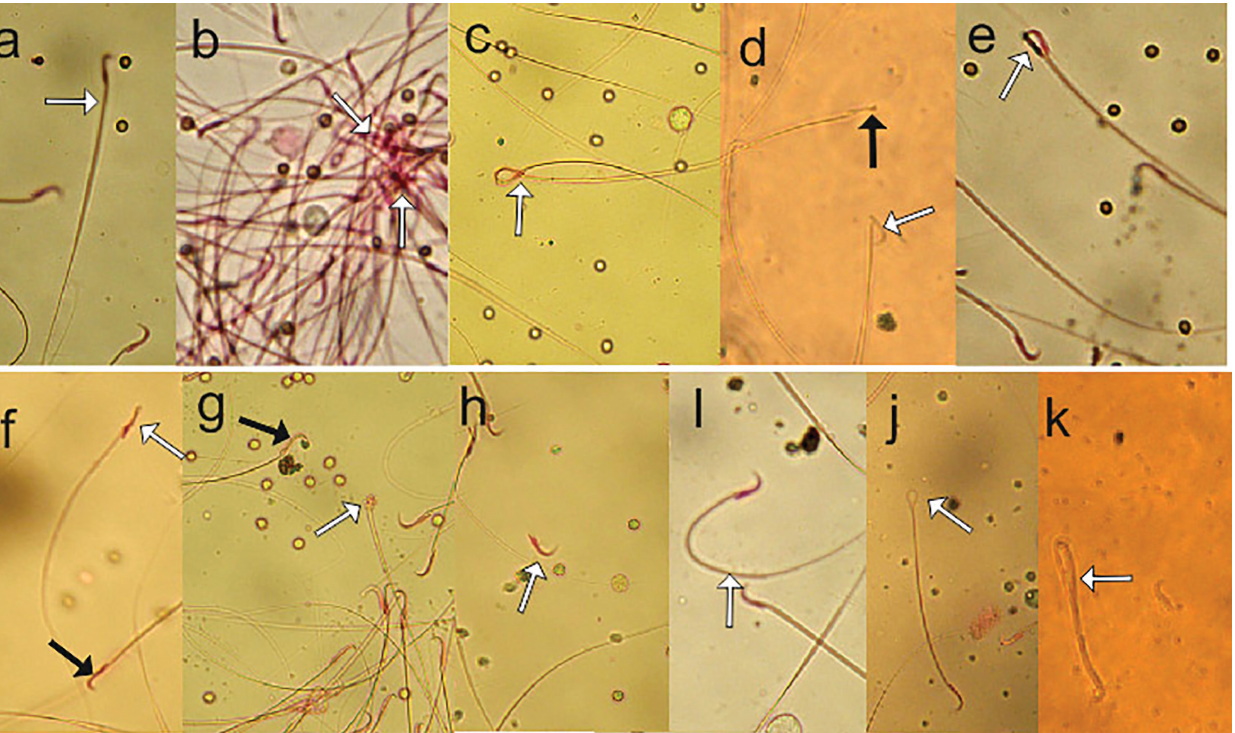
Each reading represents Mean ± SEM of 10 rats. The significance of difference was checked by t test and multiple comparison Dunnett test (compare all vs control) using a computer program graph pad (Instat software Inc). Significant difference from the